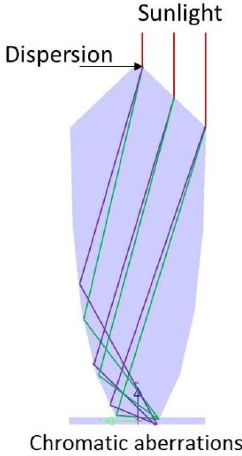
Figure 9. Mechanism of dispersion inside the P-CPC.